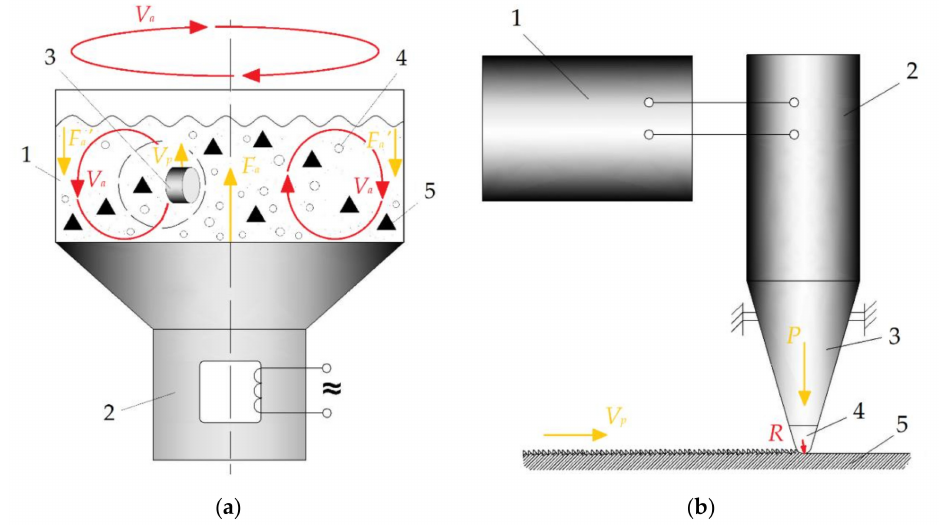
Figure 3. Schemes of ultrasonic finishing: ( a ) cavitation-abrasive finishing, where (1) is a radiator, (2) is a transducer, (3) is a part, (4) is a cavitation bubble, (5) is an abrasive particle, V a is the speed of an abrasive agent and cavitation bubble carried by acoustic flows, V p is the speed of a part, F a is an induced acoustic force, and F a ’ is a medium force response; ( b ) ultrasonic plastic deformation, where (1) is a generator, (2) is a transducer, (3) is a waveguide, (4) is a deforming tip, (5) is a part, P is a stress, R is a radius of a horn tip, and V is a speed of